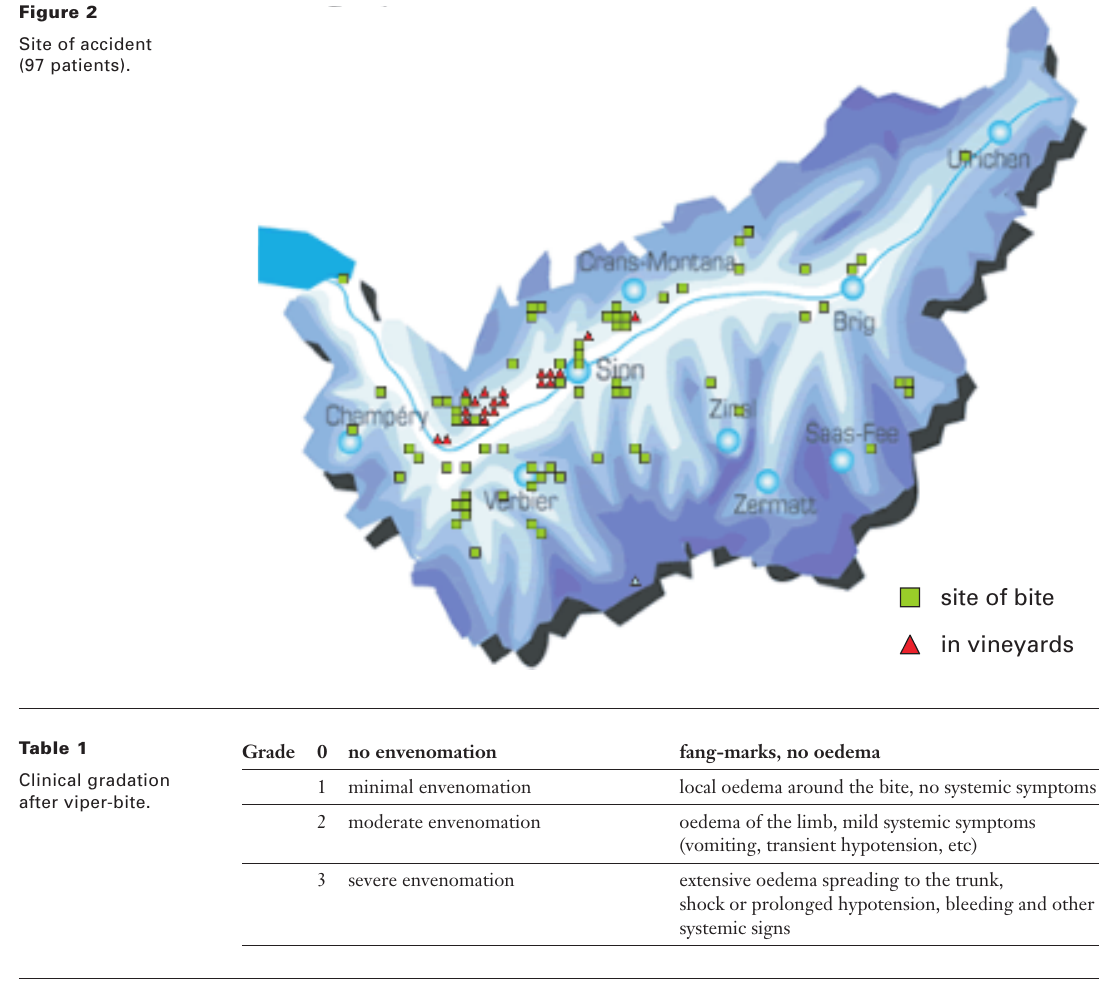
Site of accident (97 patients).